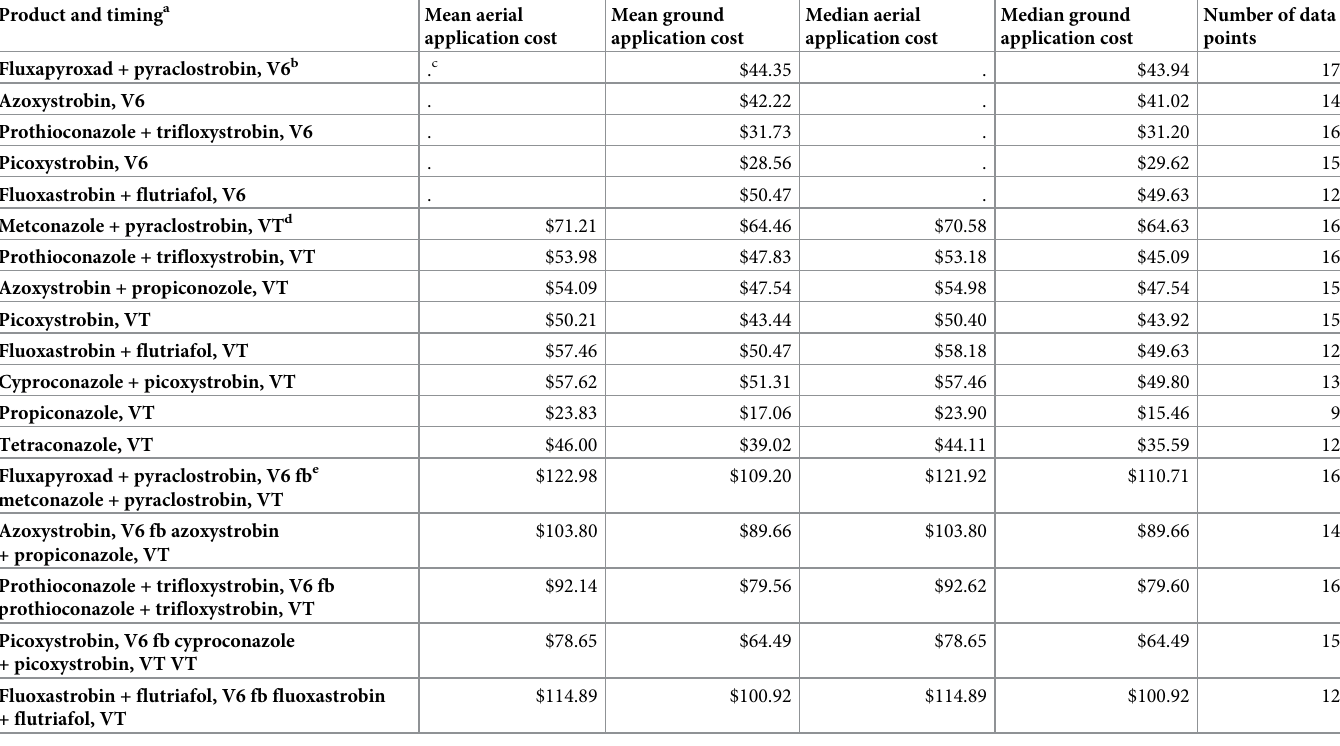
Table 5. Application costs for fungicides ($USD/ha) used in uniform fungicide application timing trials conducted in 2014 and 2015 across the United States and Ontario,